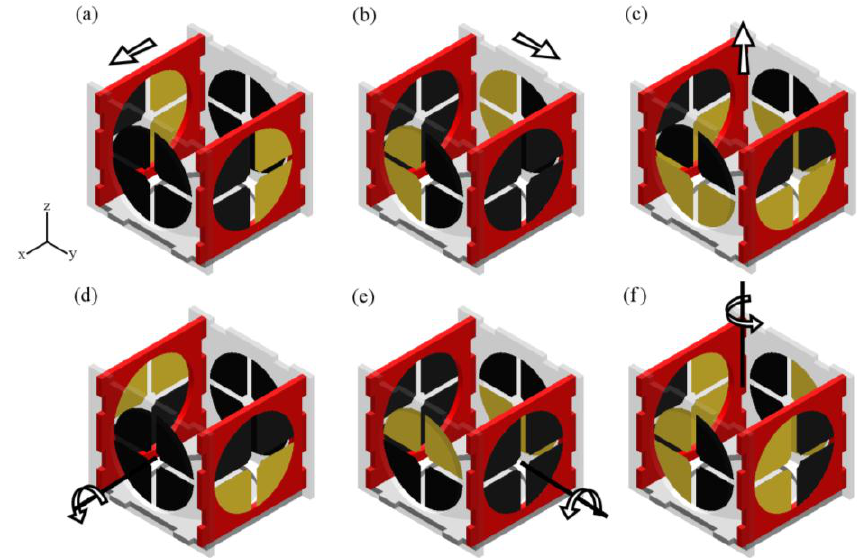
Figure 3. Translational ( a , b , c ) and rotational ( d , e , f ) displacement generated by selective activation of electrodes. Active quadrants are highlighted and passive quadrants are